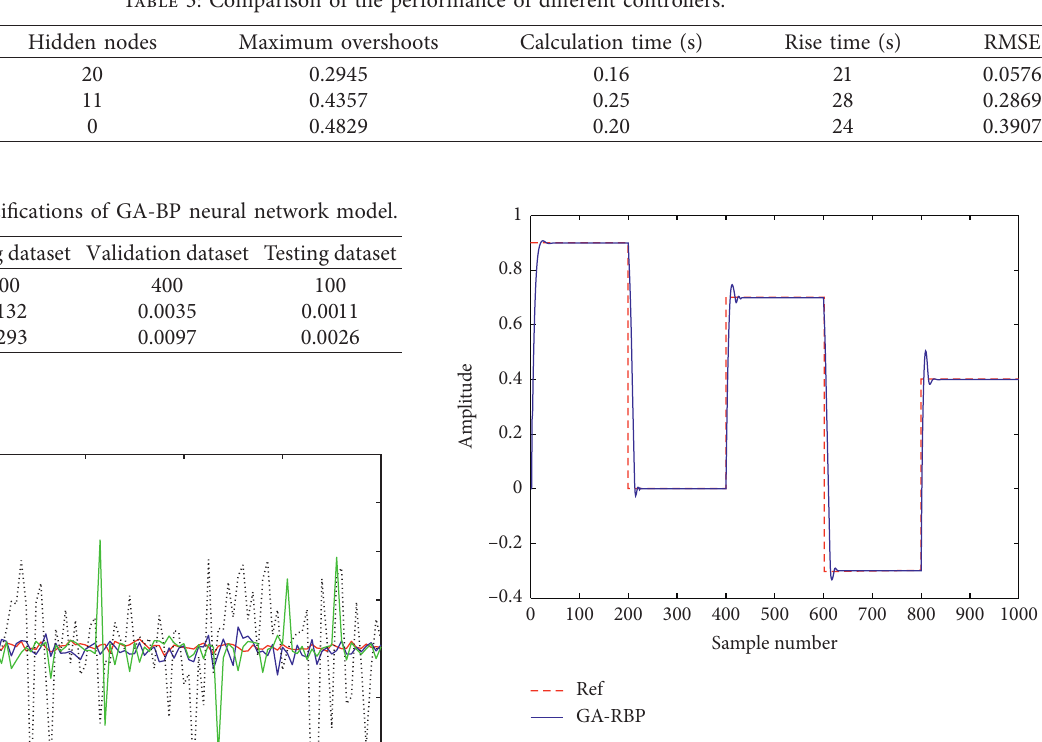
Figure 8: Tracking performance of the proposed algorithm on System II.